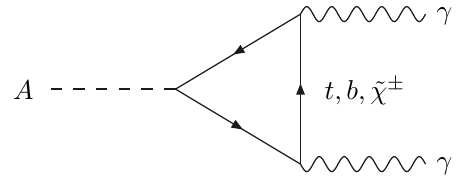
Figure 3 . Generic diagrams contributing to A → γγ at